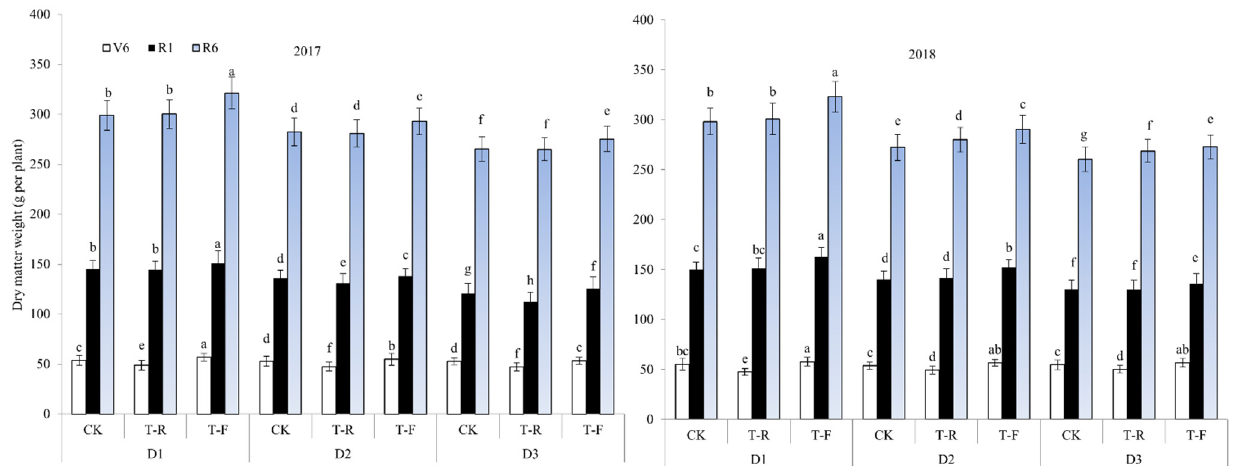
Figure 9. Dry matter weight per plant of maize under different planting patterns. At the same testing time different letters above the bars indicate that there is a significant difference between treatments at p < 0.05. D1, D2 and D3 represent maize were planted at 60,000, 75,000 and 90,000 plants ha − 1 , respectively. CK and T represent maize were planted in the conventional flat planting pattern and in the stereo-planting pattern, respectively. T-R and T-F represent maize were planted on the ridge and in the furrow, respectively. V6, R1 and R6 represent the 6-leaf stage, silking stage and physiological maturity, respectively. The vertical bar means the standard errors ( n = 3).